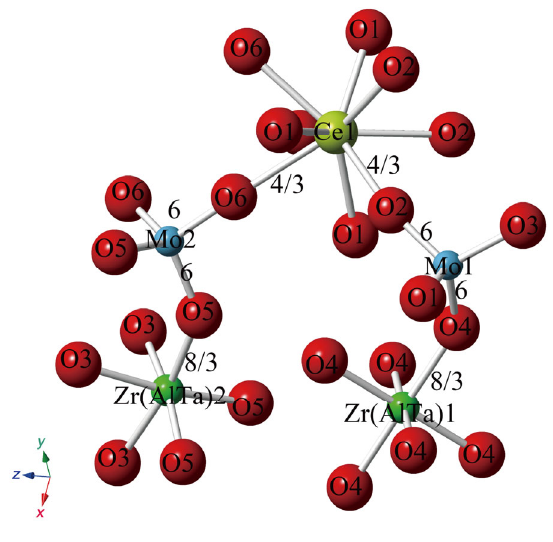
Fig. 10 Coordination and charge distribution of various ions in CZMAT ceramics.